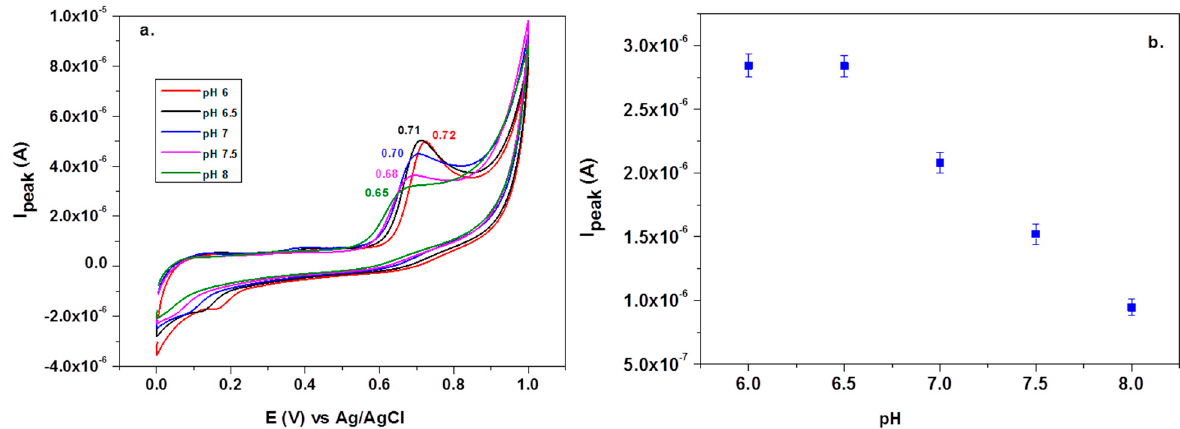
Biosensors 2021 , 11 , 36